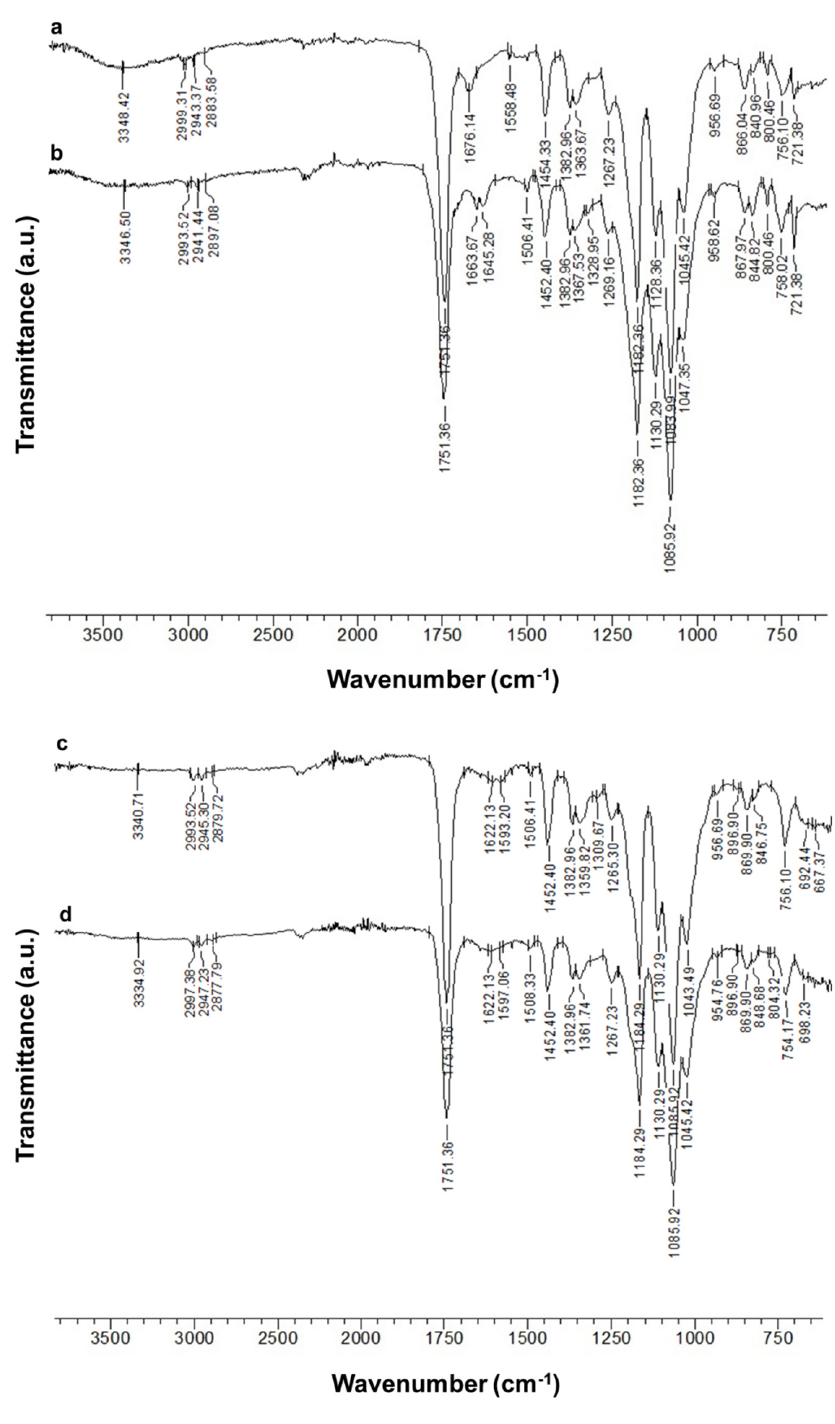
Figure 3. ATR-FTIR spectra of (a) Ch/PLA (70:30 w / w ) mat, (b) Ch-8Q/PLA (70:30 w / w ) mat, (c) Cu 2+ complex of Ch-8Q/PLA mat and (d) Fe 3+ complex of Ch-8Q/PLA mat.